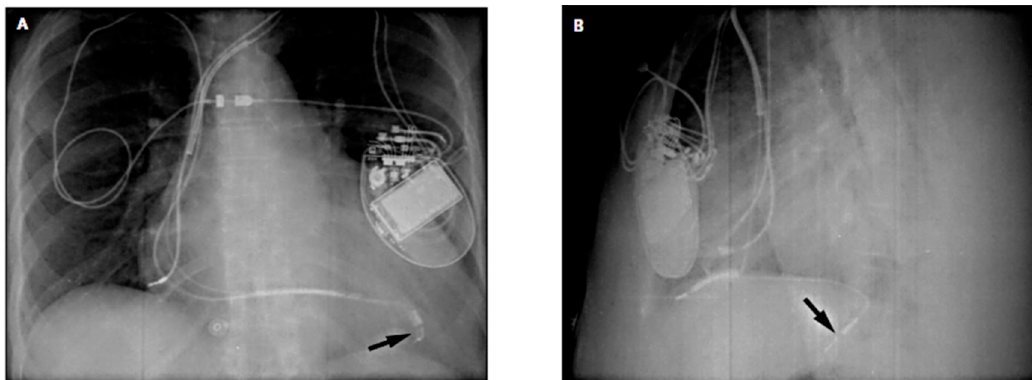
Figure 3. Chest radiographs showing lead placements. ( A ) Posteroanterior and ( B ) lateral chest radiographs showing tip of a large left ventricular lead (arrows) in a tributary of the middle cardiac vein. Despite proximity of the lead to the left hemidiaphragm, phrenic nerve stimulation did not take place. The right ventricular lead points anteriorly toward the rib cage. Reproduced with permission from reference [29].